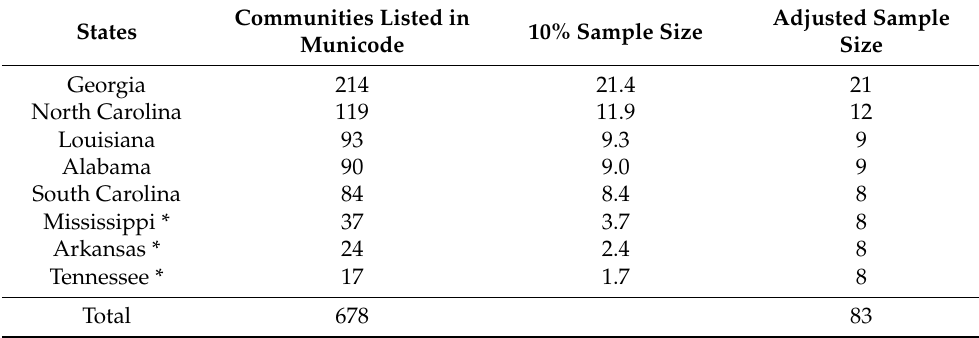
Table 1. Total number of communities represented in Municode and the corresponding adjusted sample size selected by state.